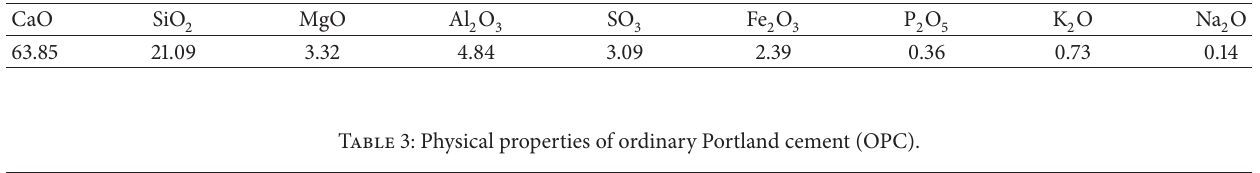
Table 2: Chemical composition of binder (%).